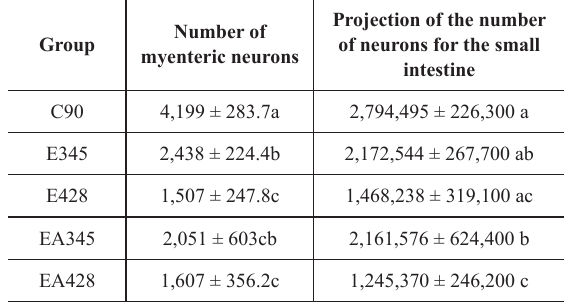
Means followed by the same lowercase letters in the same column do not differ from one another according to Tukey’s test ( p < 0.05).